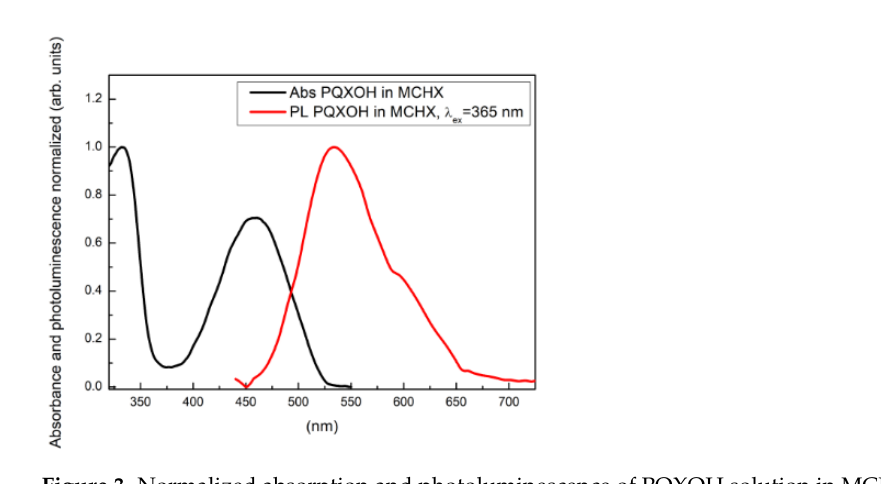
Figure 3. Normalized absorption and photoluminescence of PQXOH solution in MCHX solution. Table 2. Position of the absorption and emission of the tested PQXOH in various solvents.